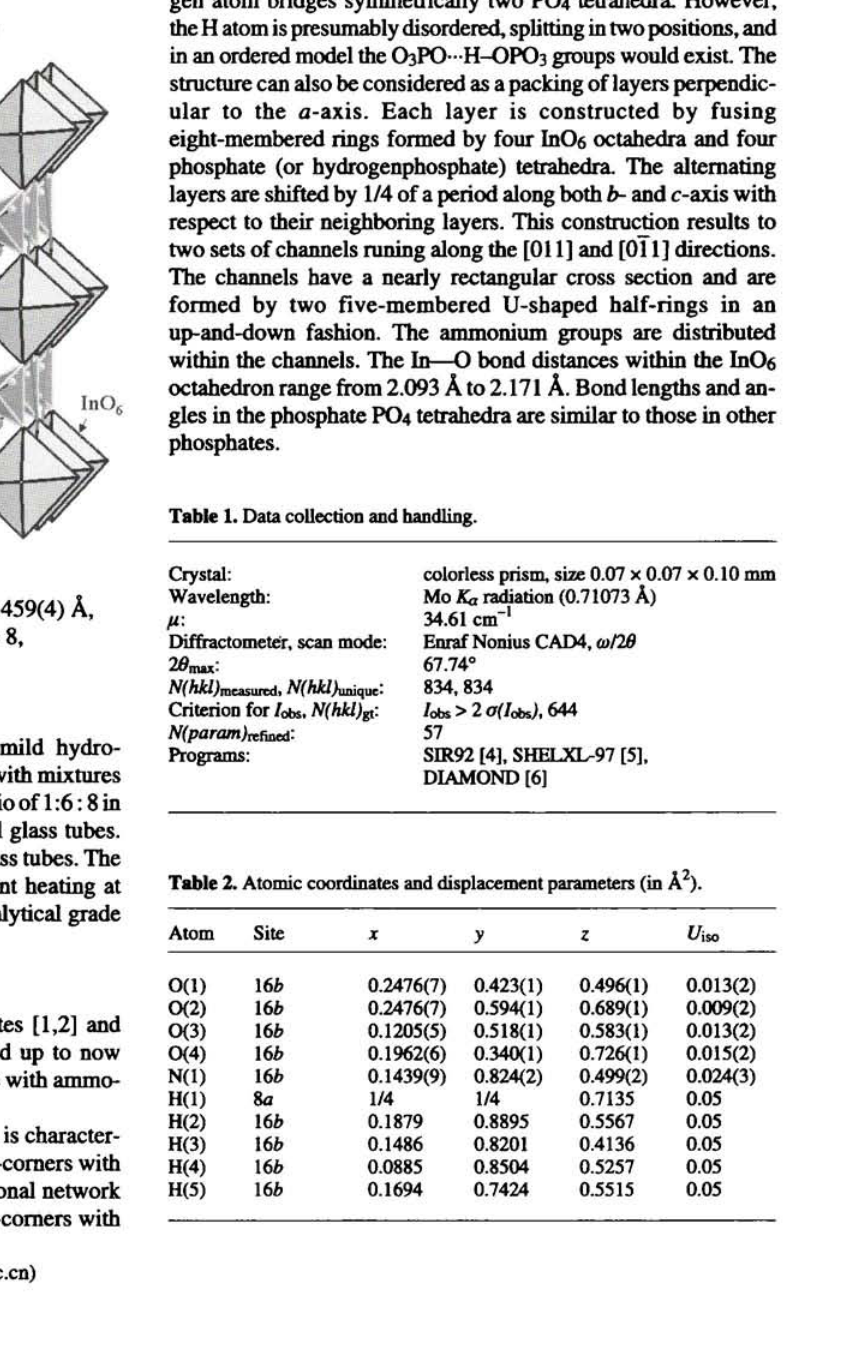
Table 2. Atomic coordinates and displacement parameters (in Â 2